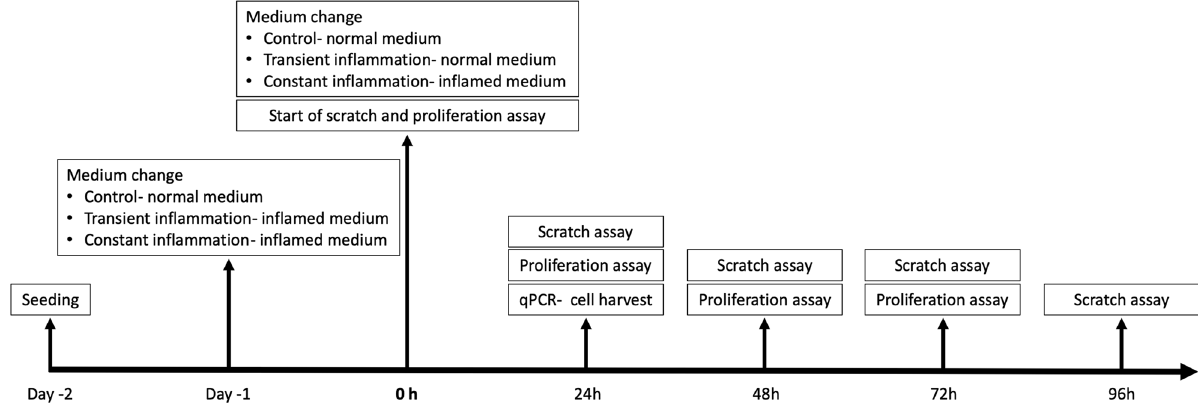
Figure 2. Study timeline detailing the experimental protocol. Gene expression, proliferation and migration of tenocytes of all five species (human, mouse, rat, sheep, horse) were compared under standard culture conditions (healthy control) as well as under transient (24 h) and constant exposure to inflammatory stimuli (10 ng/ml IL1β and 10 ng/ml TNFα). After 24-h exposure to inflammation, the transient inflammation group received fresh culture medium, while for the constant inflammation group fresh medium was again supplemented with inflammatory